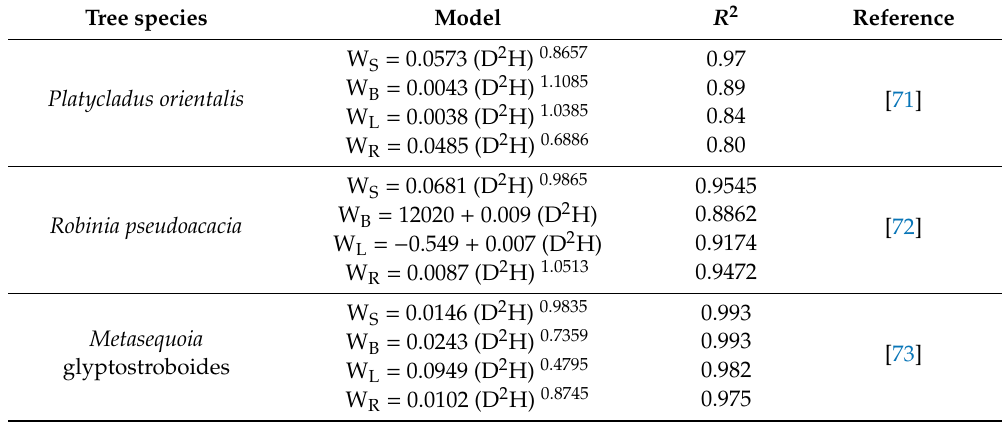
Table A2. Allometric biomass equations for trees, used for calculating quadrat biomass. Tree